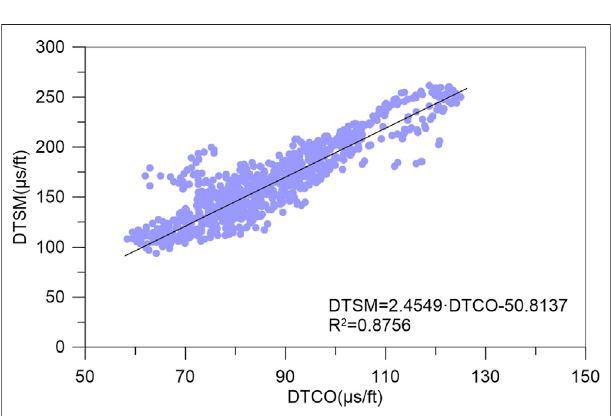
FIGURE 5 | The relationship between the compressional wave transit time and shear wave transit time in the LD-A gas fi eld.